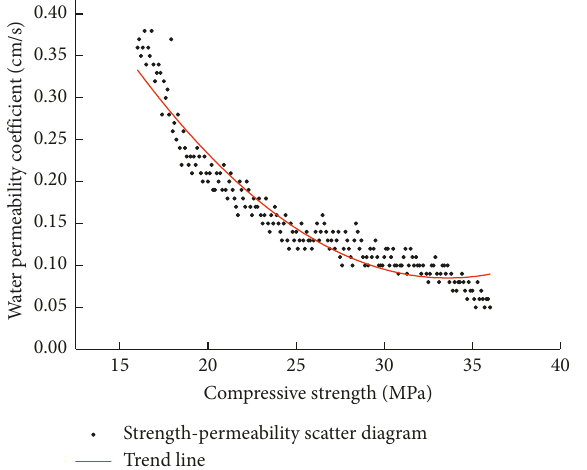
Figure 17: Relationship between permeability and strength of open-graded